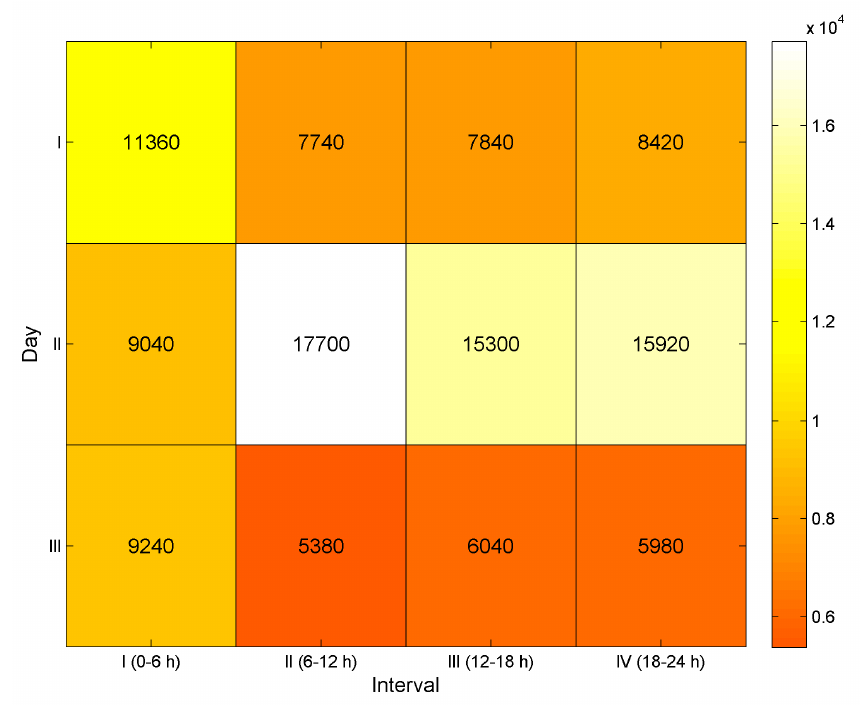
Figure 3. Distribution of tweets in the Twitter dataset.